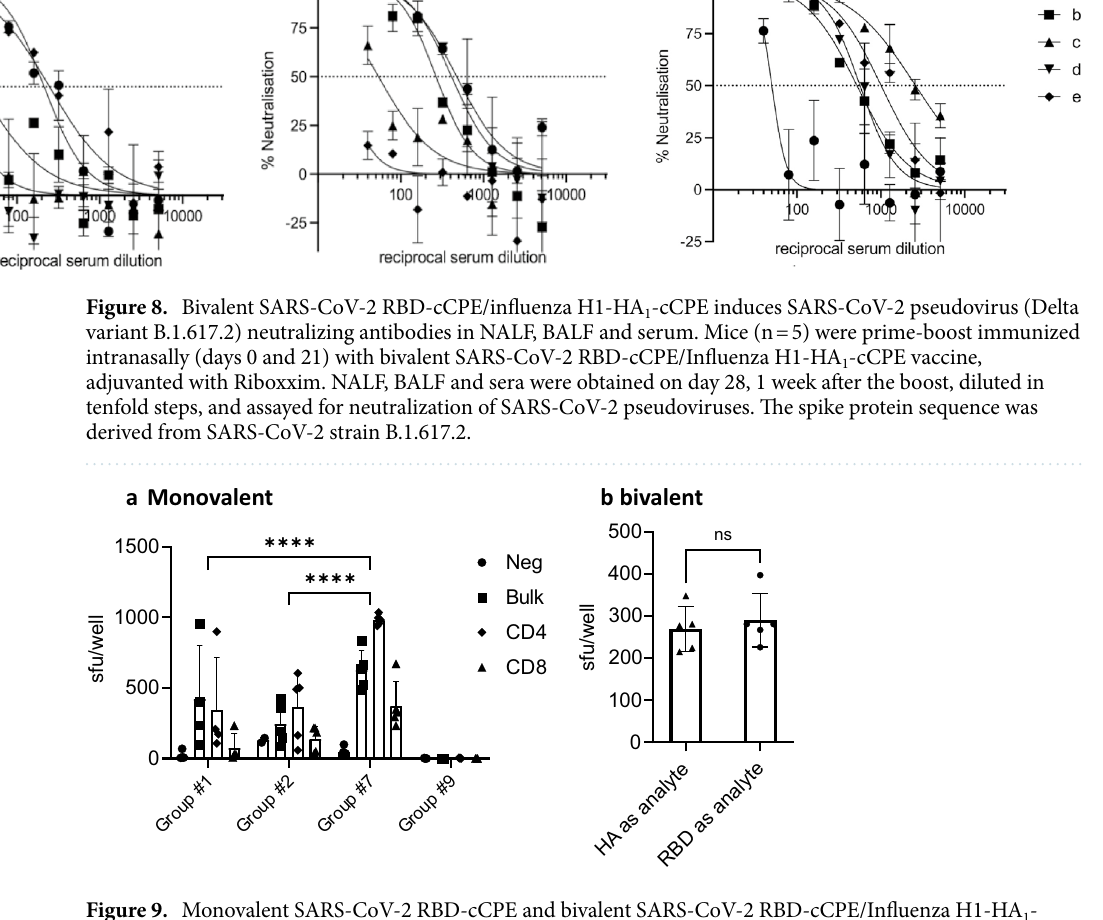
Figure 9. Monovalent SARS-CoV-2 RBD-cCPE and bivalent SARS-CoV-2 RBD-cCPE/Influenza H1-HA 1 - cCPE vaccines induces CD4 and CD8 T-cell responses against recombinant SARSCoV-2 RBD or influenza H1-HA 1 . Monovalent SARS-CoV-2 RBD-cCPE and bivalent SARS-CoV-2 RBD-cCPE/Influenza H1-HA 1 -cCPE vaccines induce CD4 and CD8 T-cell responses against recombinant SARS-CoV-2 RBD or influenza H1-HA 1 protein. ( a ) Mice were prime-boost immunized intranasally (days 0, 21) with either monovalent non-targeted RBD, strain Wuhan-Hu-1 (group #1), M-cell targeted RBD (RBD-cCPE, group #7), both adjuvanted with Riboxxim or PBS (group #9). On day 28 bulk splenocytes (Bulk, squares) or splenocytes MACS-depleted for either CD8 (CD4, rhombus) or MACS-depleted for CD4 (CD8, triangles) were analyzed for IFNγ production upon restimulation with recombinant RBD or recombinant ACE2 as control (Neg control, dots) in ELISPOT. Data are presented as means + SD. Statistics: two-way ANOVA followed by Tukey’s multiple comparisons test with ns not significant; *** p ≤ 0.001; **** p < 0.0001. The individual CD4 and CD8 T-cell responses were statistically significantly different between group #1 and #7 ( p = 0.0018 and p = 0.0051, respectively) and between group #2 and group #7 ( p = 0.0014 and p = 0.0203, respectively), by one-way ANOVA. ( b ) Mice were prime- boost immunized intranasally with bivalent SARS-CoV-2 RBD-cCPE/influenza H1-HA 1 -cCPE, adjuvanted with Riboxxim. On day 28 splenocytes were analyzed for IFNγ production upon restimulation with recombinant RBD (dots) derived from SARS-CoV-2 strain Wuhan-Hu-1 or an H1-HA 1 consensus sequence (squares)